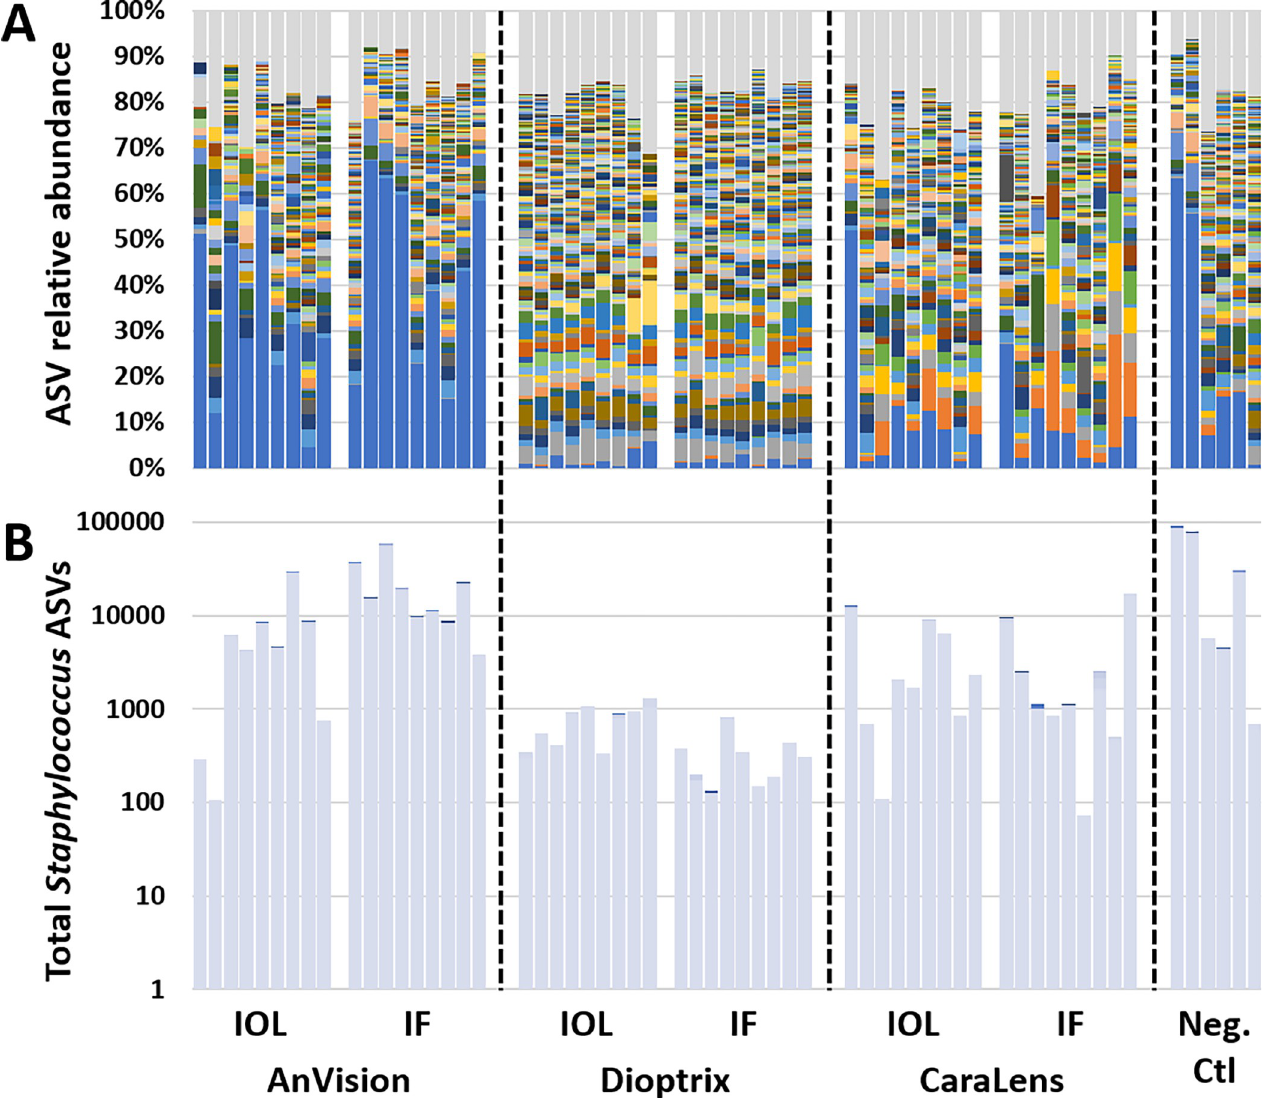
Fig 1. Composition of each manufacturer. Intraocular lenses (IOL) and packaging fluid yield varying microbial taxonomic profiles (A). Relative taxonomic abundance plots of the genus Staphylococcus for IOL/packaging fluid samples (according to manufacturer) and negative controls. (B).